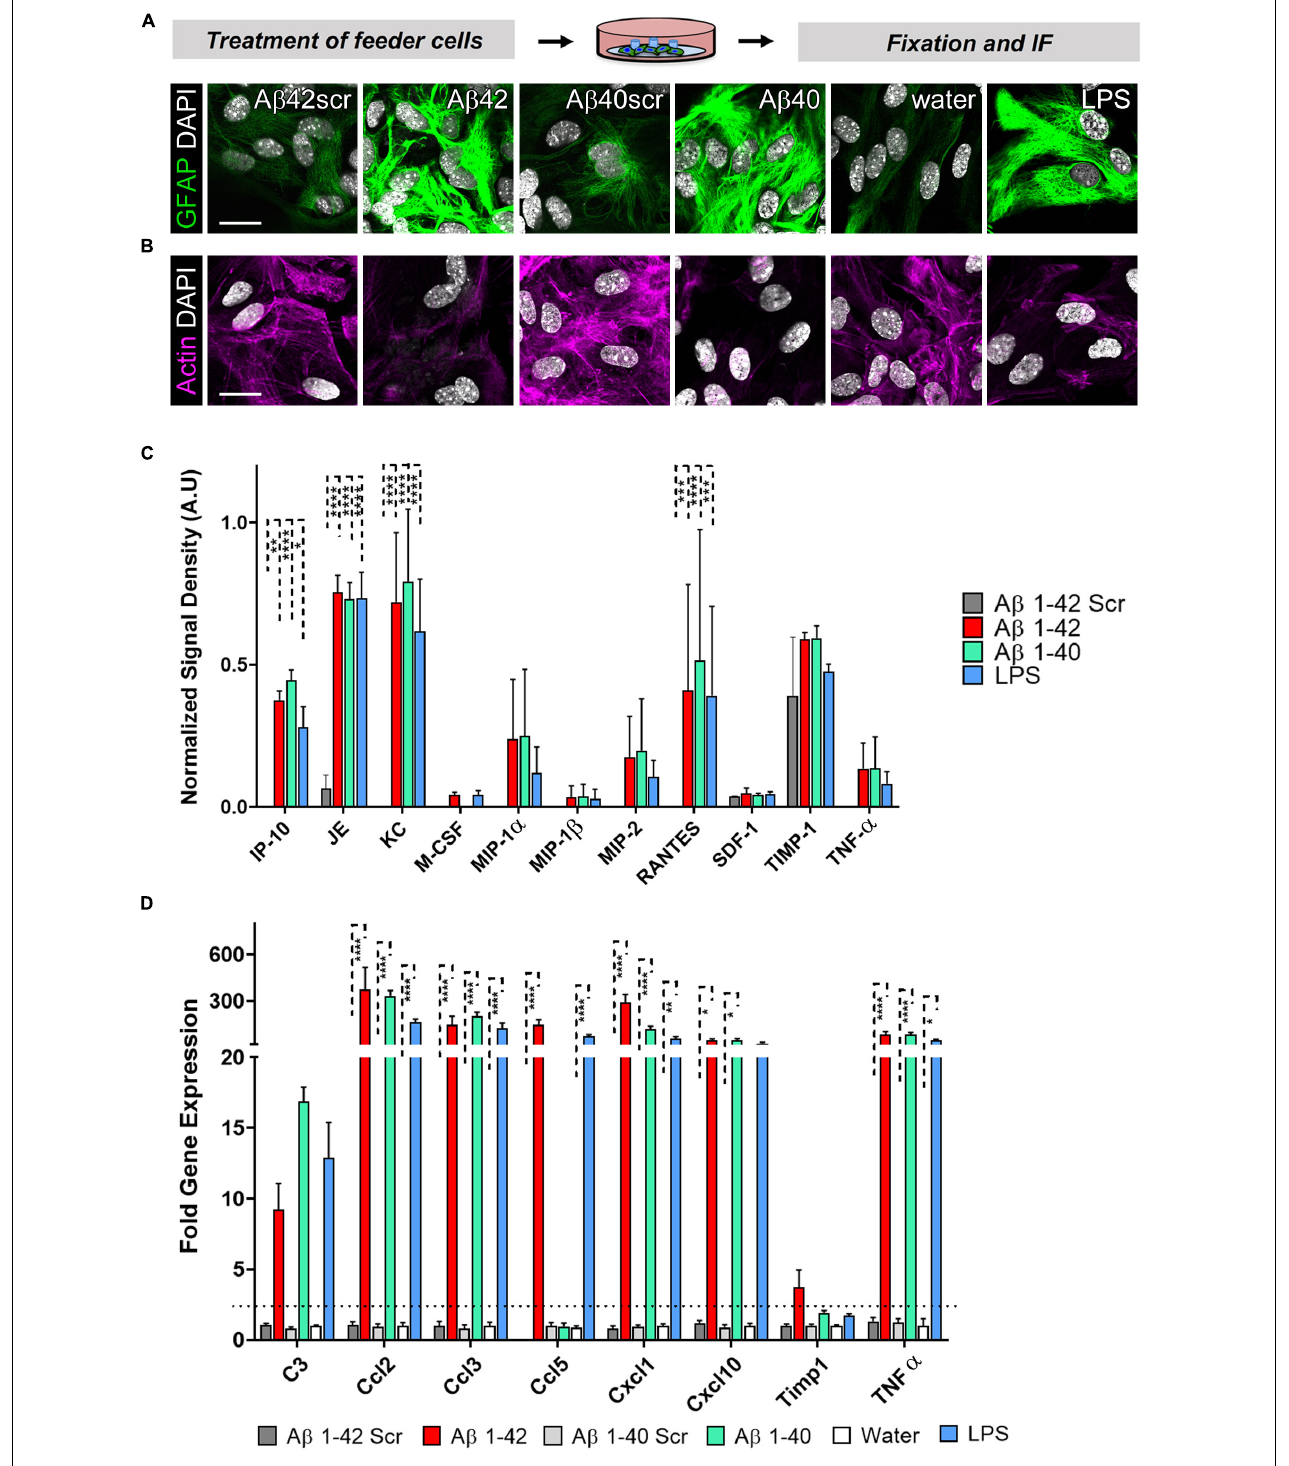
FIGURE 7 | Astrocytes display an altered morphology and a distinctive cytokine expression pattern after treatment with A β 42, A β 40, or LPS. Astrocytes were exposed to LPS (100 ng/ml), A β 40 (2.5 µ M), or A β 42 (2.5 µ M), or the respective controls water, A β 40scr (2.5 µ M), or A β 42scr (2.5 µ M) for 24 h. (A+B) Representative immunofluorescence staining with (A) the astrocyte marker GFAP or (B) AlexaFluor647-Phalloidin for visualization of actin filaments show reactive astrocyte phenotypes with induction of GFAP and cytoskeleton (actin) rearrangement under all three treatment conditions A β 42, A β 40, or LPS in contrast to the respective controls, scale bar = 20 µ m ( n = 6; 2 experiments with 2–4 independent replicates each). (C) Release of cytokines to the cell culture supernatant after